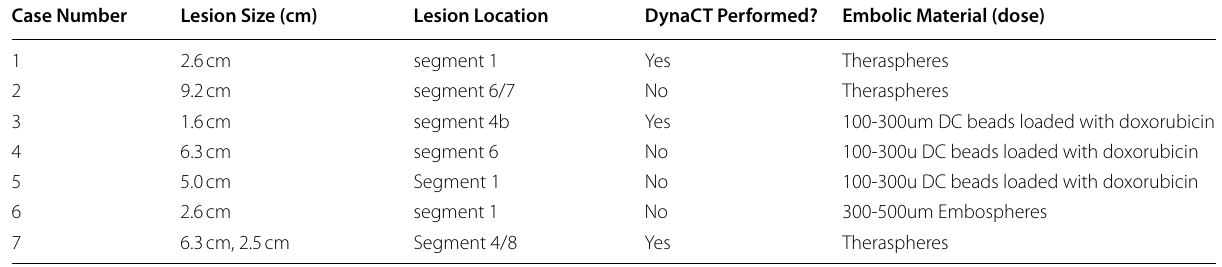
Table 2 Technical details about embolization material, and lesion